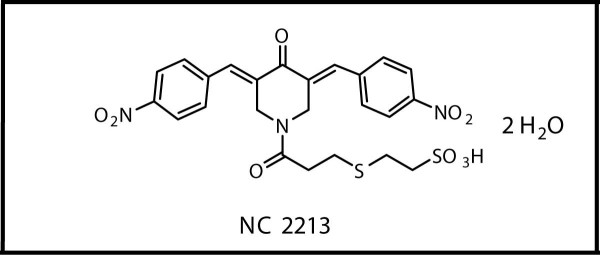

Structure of NC2213.